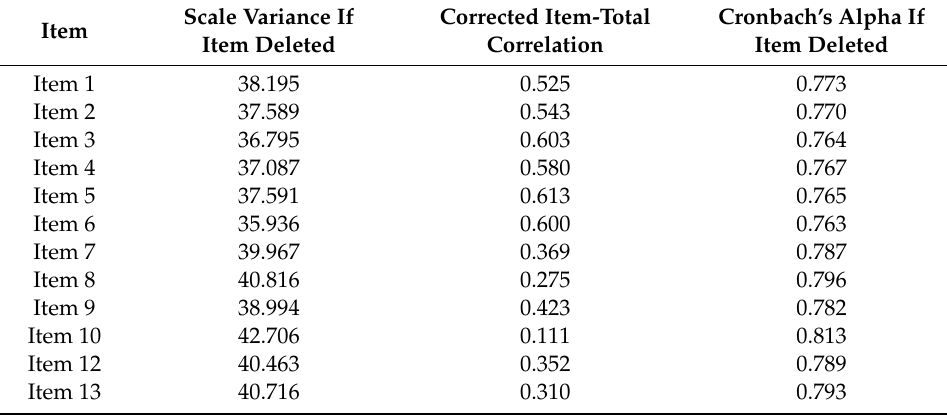
Table 3. Discrimination index of the